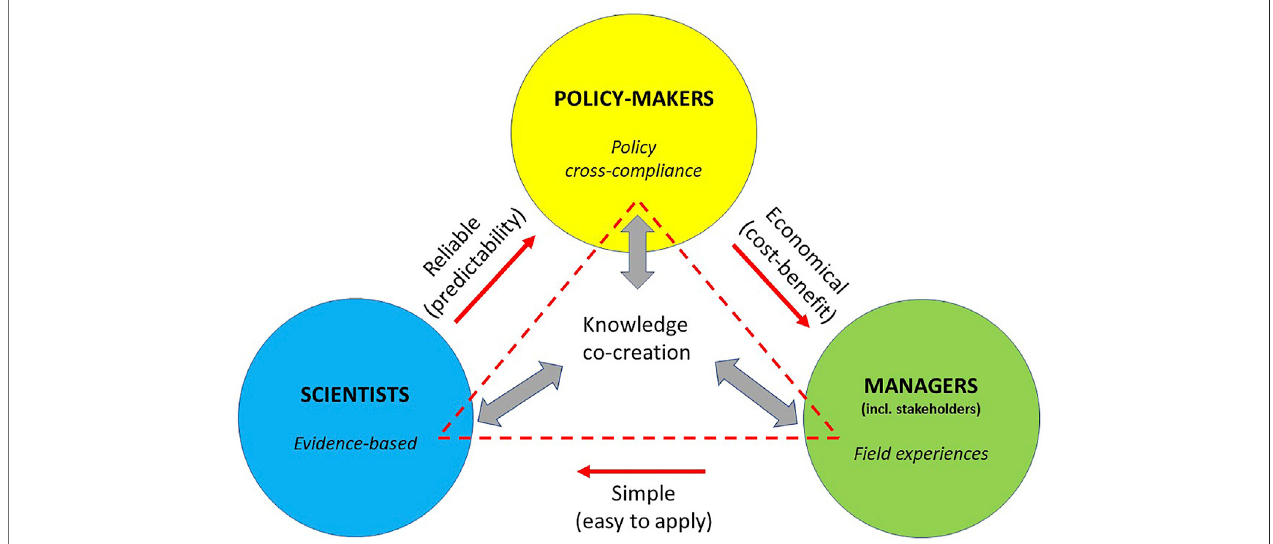
FIGURE 2 | “ Knowledge co-creation triangle ” for enhanced riparian zone management. The Figure highlights, fi rst, that all three groups (scientists, policy-makers and managers) create knowledge and contribute to the sustainable management of riparian zones. Second, scientists contribute with the evidence-based approach, policy-makers assure cross-compliance among all relevant policies related toriparian zones and managers provide fi eld experiencessupported bythe localknowledge. Third,red arrowsindicate addressing directionofscientists,policy-makersand managersabouttheapproaches usedinriparianzonemanagementthatshouldbe reliable, economical and